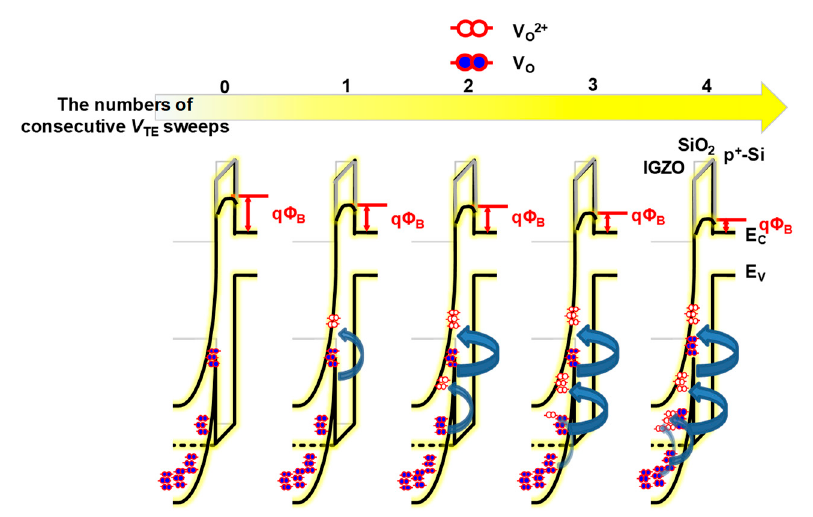
Figure 6. Energy band diagram for the evolution of Φ B with the increase in the number of consecutive positive V SS sweeps.